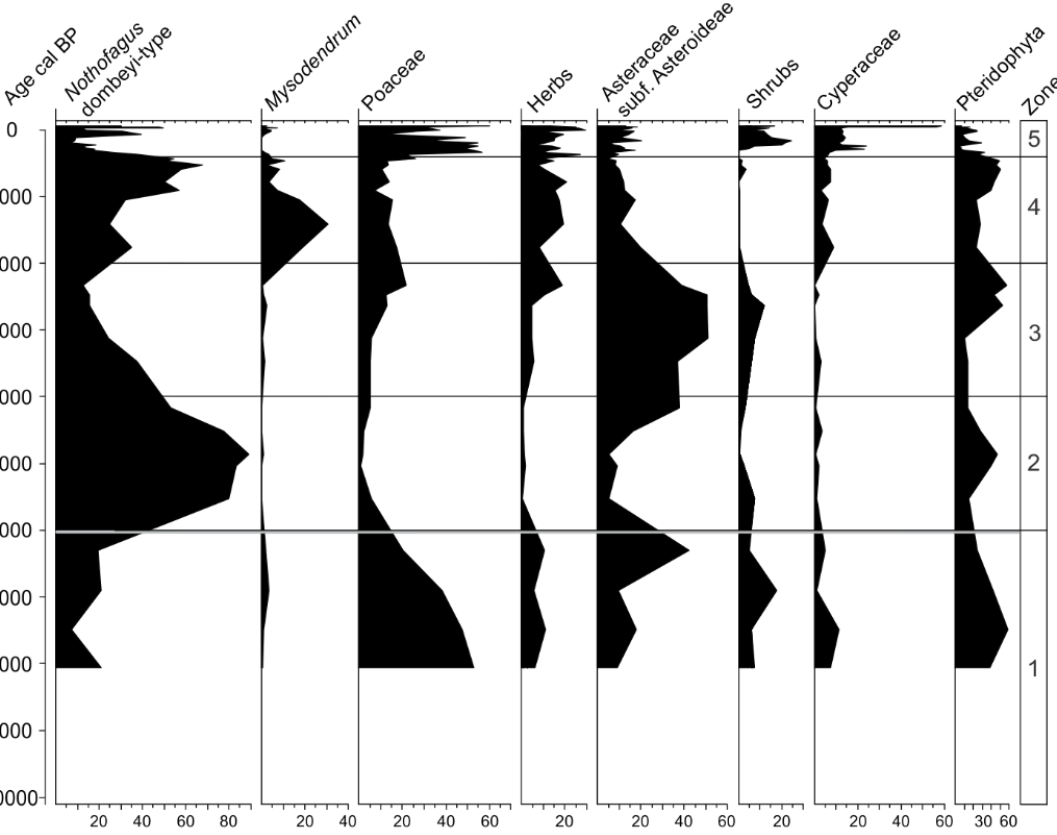
Figure 6. Península Avellaneda Bajo (PAB) pollen diagram expressed in percentages (%). Pollen zones obtained by cluster analysis. The superposed grey line indicates the position of the tephra